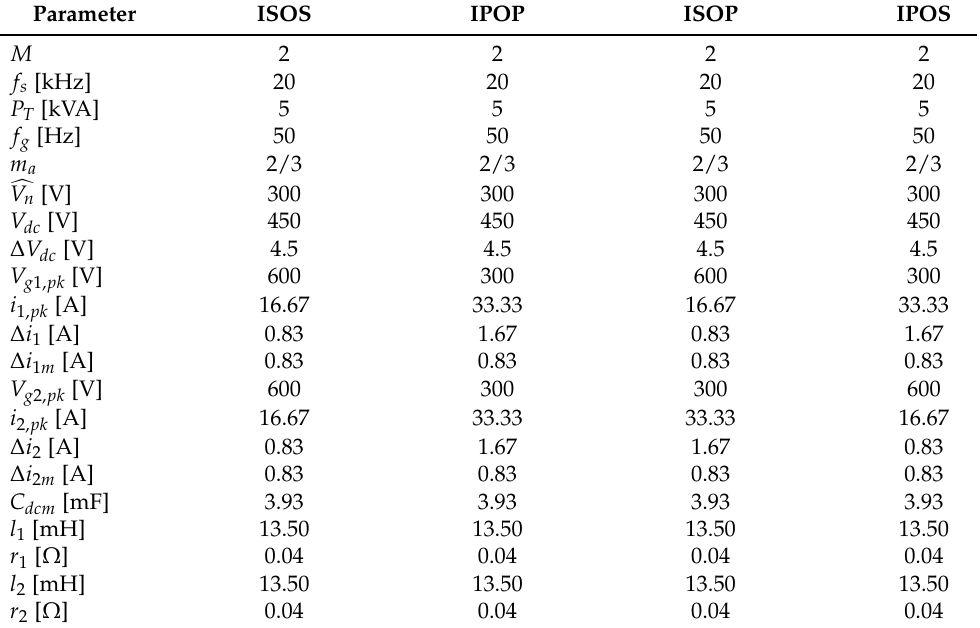
Table 7. Sizing for the different configurations of the 2-modules CHB-B2B